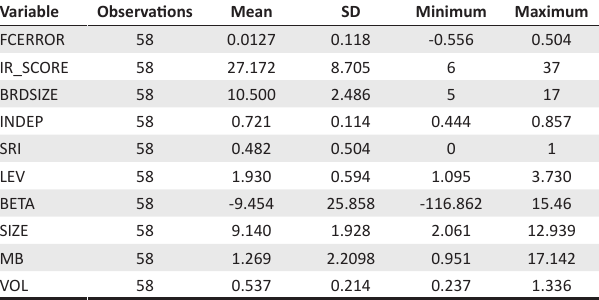
TABLE 2: Descriptive statistics: Analysts’ forecast